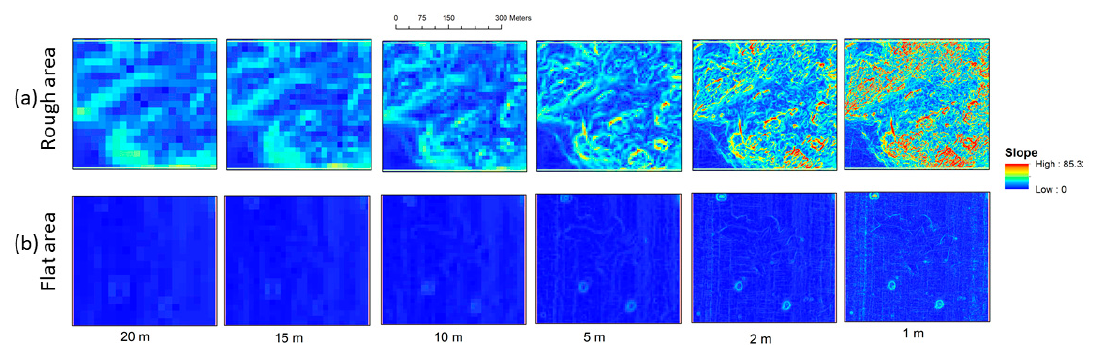
Figure 10. Seafloor slopes for the rough ( a ) and flat ( b ) area computed using the Horn method for cell sizes varying from 1 m (right) to 20 m (left). Dimensions of each area are ~400 m × 400 m. See Figure 4 for location.